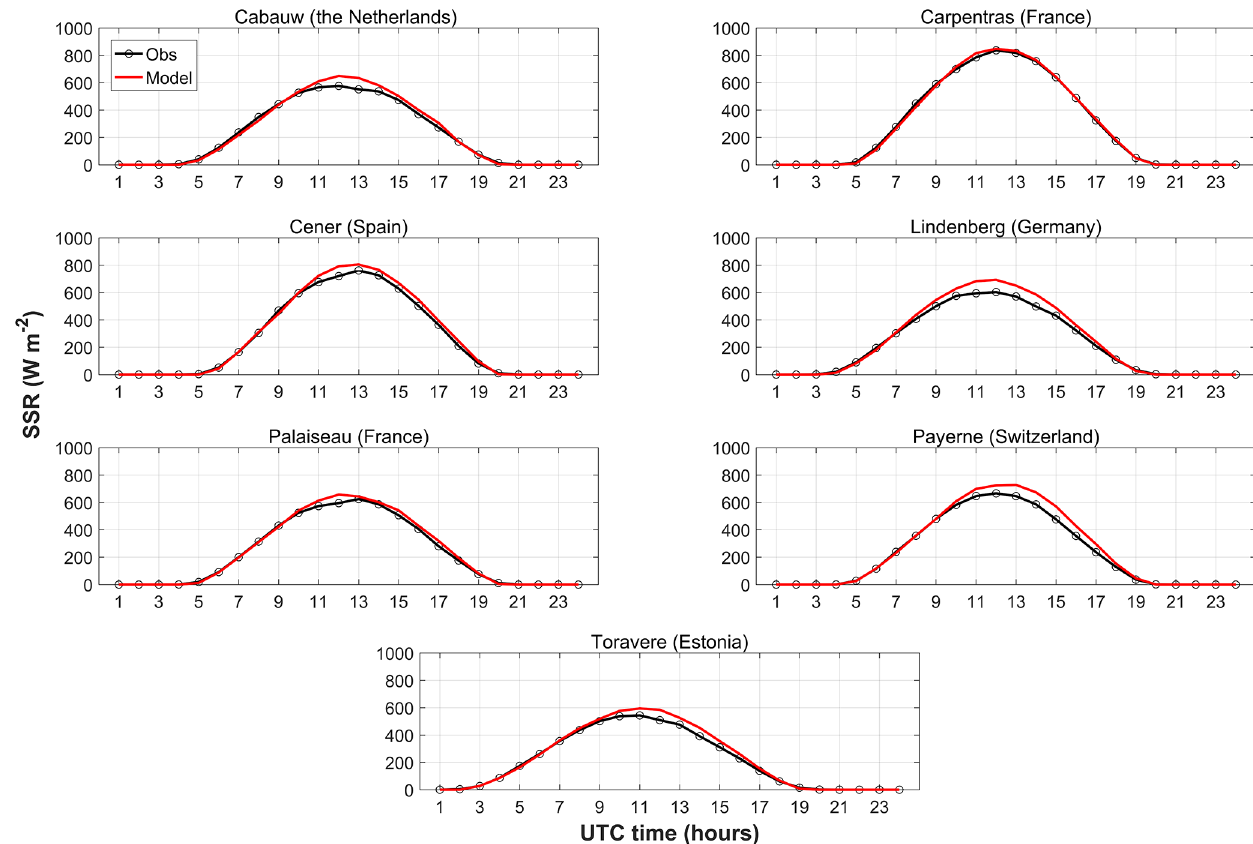
Figure 2. Mean diurnal profiles of observed and modeled (BASE scenario) SSR at seven European sites from the BSRN network in summer